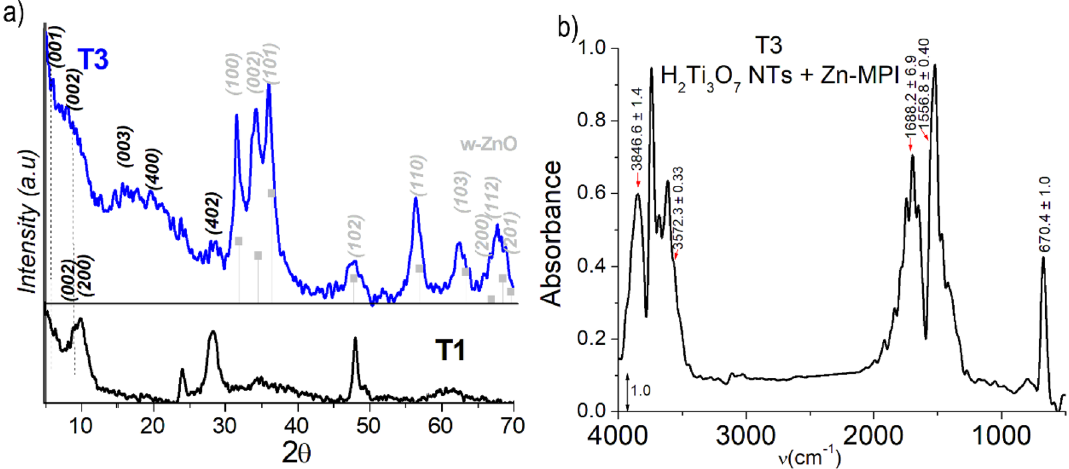
Figure 11. X-ray diffraction of T3 ( a ) contrasted with T1 and ZnO (ICDD card 361451). And Normalized IR spectrum of T3 in the range of 500–4000 cm −1 ( b Figure 11a show an XRD pattern obtained from T3. The crystallinity of the T3 product is relatively poor; however, at first glance its XRD pattern seems to correspond mainly to the overlapping of Bragg reflections of both w-ZnO and original nanotubes, including three of the five characteristic diffraction peaks of pristine nanotubes. Namely, peaks near the nanotubes; peculiar reflections at 2θ = 10.36° (200), 20.72 (400), and 28.3° (402). Moreover, there is a cluster of reflections of relatively low intensity in the low-angle region of the diffrac- togram, which is similar to that discussed for sample T2 and that could be attributed to a set of structures with different interlaminar separations (Figure S26 and Table S3 in ESI). The probable presence of by-products from the reaction of the nanotubes with DEZ with excess water, such as zinc titanates 12,90 and small zinc hydroxides crystallites 80 , leading to multiple low intensity reflections in areas not obscured by diffraction signals of the more